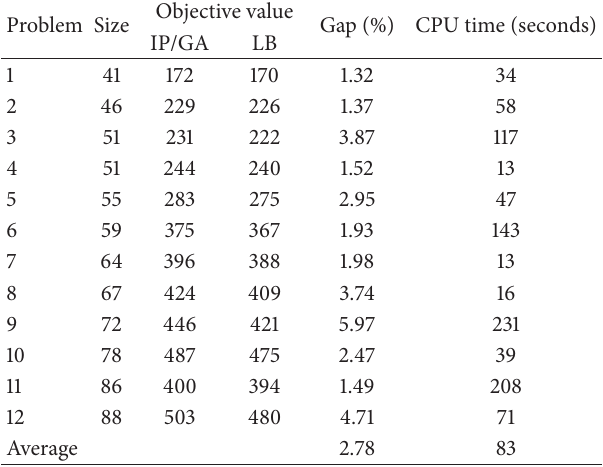
Table 3: Experimental results for the practical problems. Problem Size